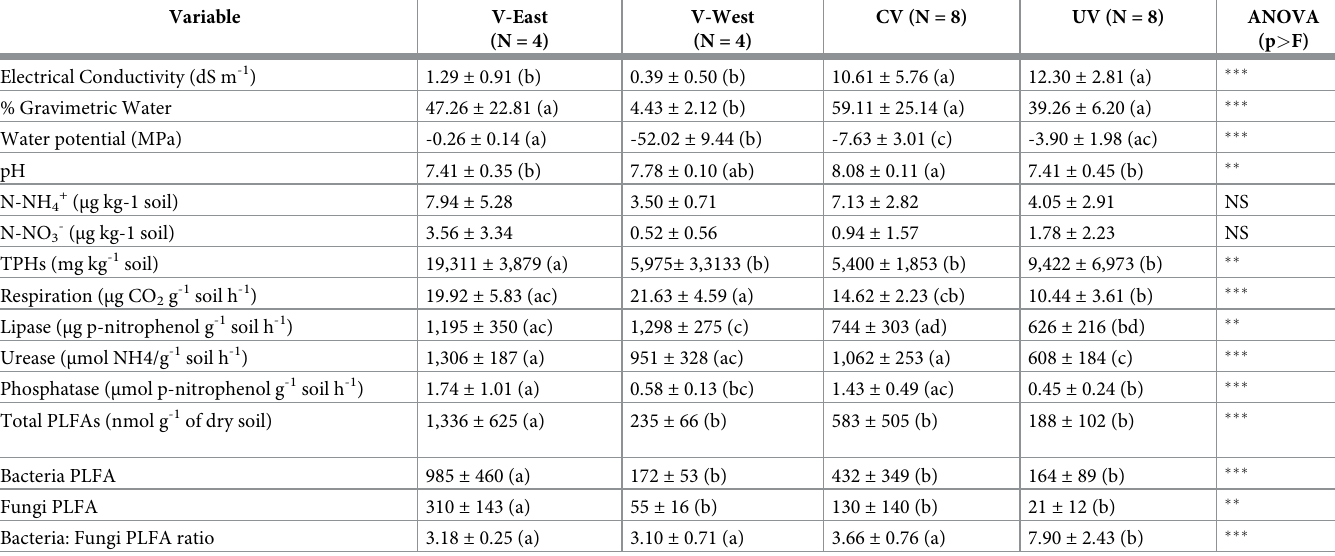
Table 1. Physicochemical differences among the sample